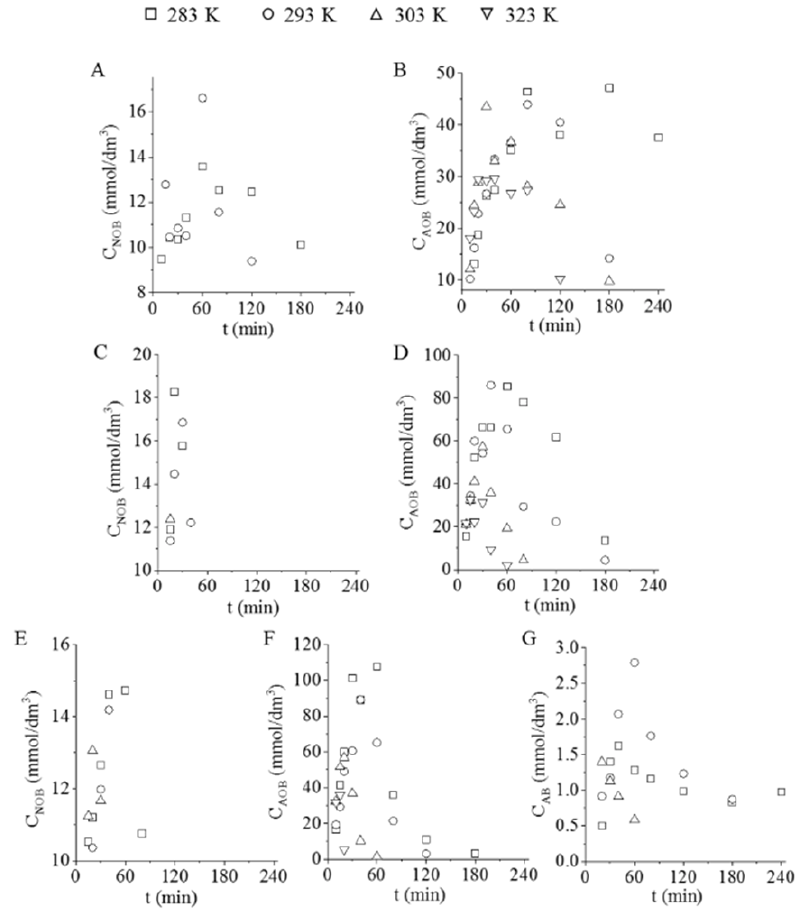
Figure 6. The concentration of the intermediates (nitrobenzene-NOB, azoxybenzene-AOB, and azobenzene-AB) in the reaction media vs. time of hydrogenation, using Pd/GCF ( A , B ), Pd/GCF-AC1 ( C , D ), and Pd/GCF-AC2 ( E – G ) catalysts.